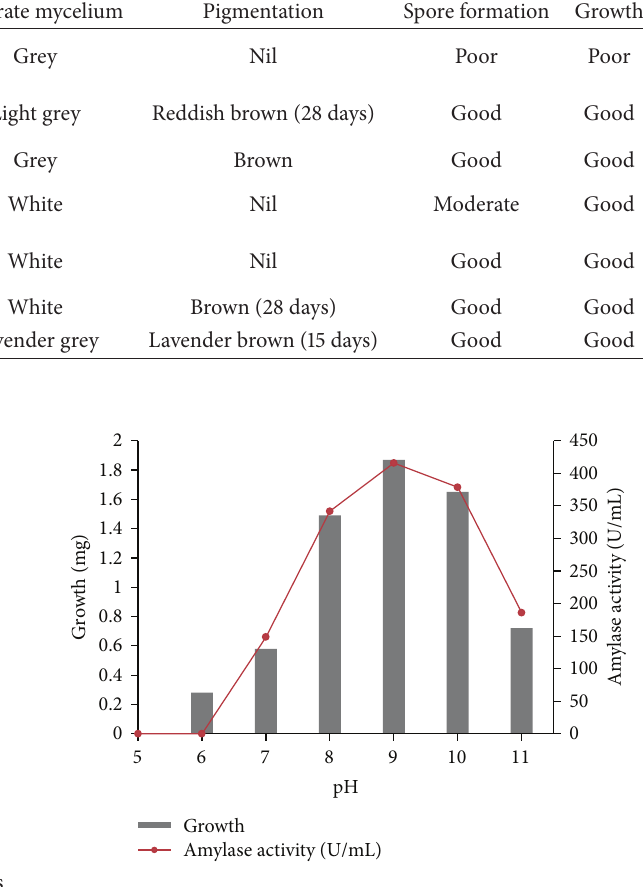
Figure6:EffectofinitialpHongrowthandamylaseactivityofBTSS 1001.